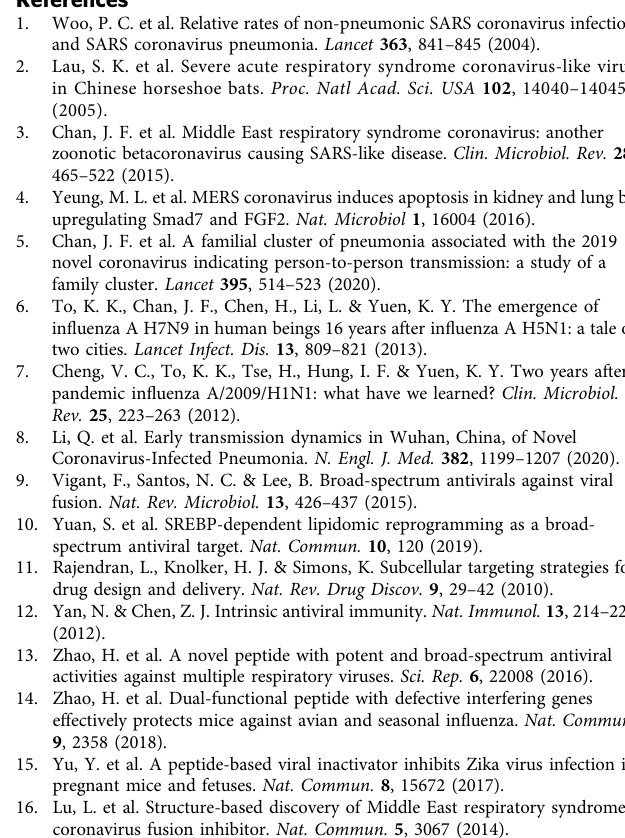
Table 2) for detecting SARS-CoV-2, MERS-CoV, SARS-CoV, H1N1, H7N9, and rhinovirus using LightCycle ® 480 SYBR Green I Master (Roach, USA).